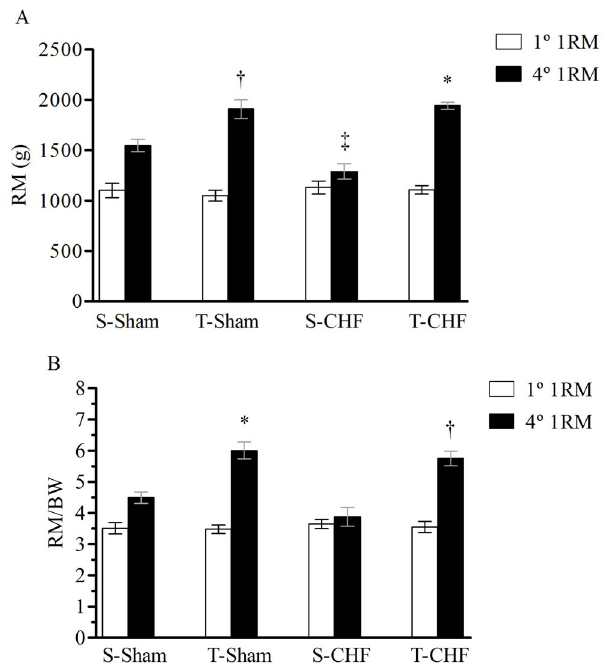
Figure 2. Absolute values for one repetition maximal test (1RM). ( A ). Relative values for one repetition maximal test (1RM) ( B ). Values are means 6 SE; n=8 for all groups. S-Sham, sedentary sham rats; T-Sham, training sham rats; S-CHF, sedentary chronic heart failure rats; T-CHF, training chronic heart failure rats. * P , 0.001 compared to sedentary groups. { P , 0.01 compared to sedentary groups ` P , 0.05 compared to S-Sham group.